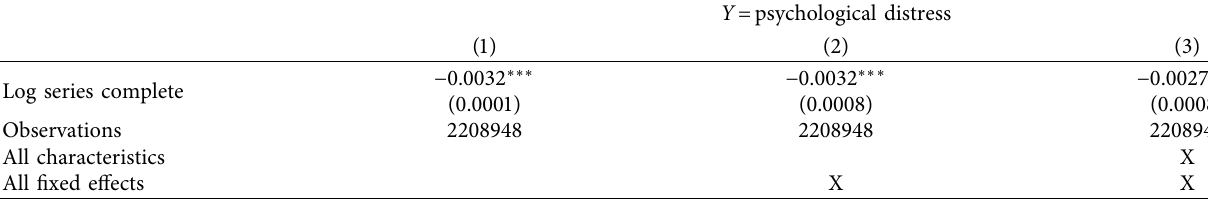
Table 6: Vaccination and psychological